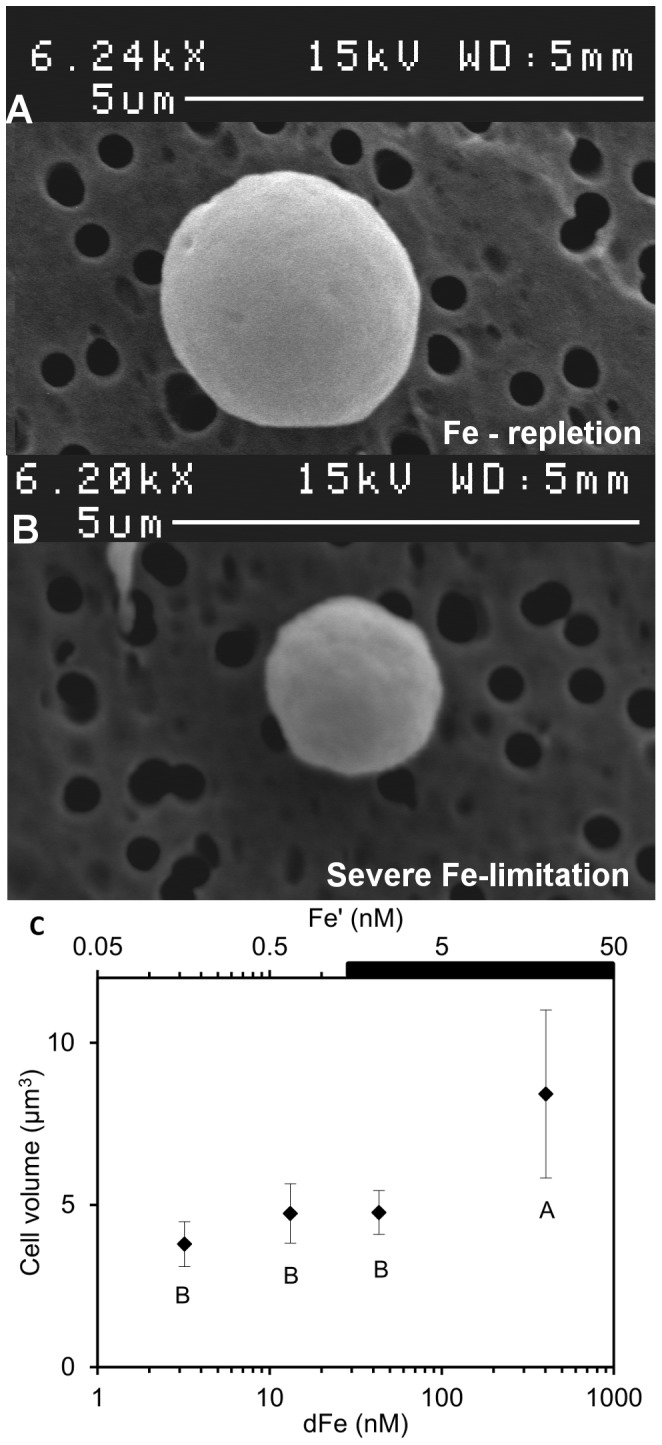
Influence of Fe availability on C. watsonii biovolume.Scanning electron microscopy photography of C. watsonii growing in (A) Fe-replete condition (dFe = 403.3 nM) and (B) severe Fe-limited condition (dFe = 3.3 nM). (C) Mean biovolume of C. watsonii related to dFe and Fe′ concentrations, in log scale. Error bars represent standard deviation; different letters correspond to statistically different means (p<0.05) and the black bar indicates the region of expected Fe hydroxide precipitation.